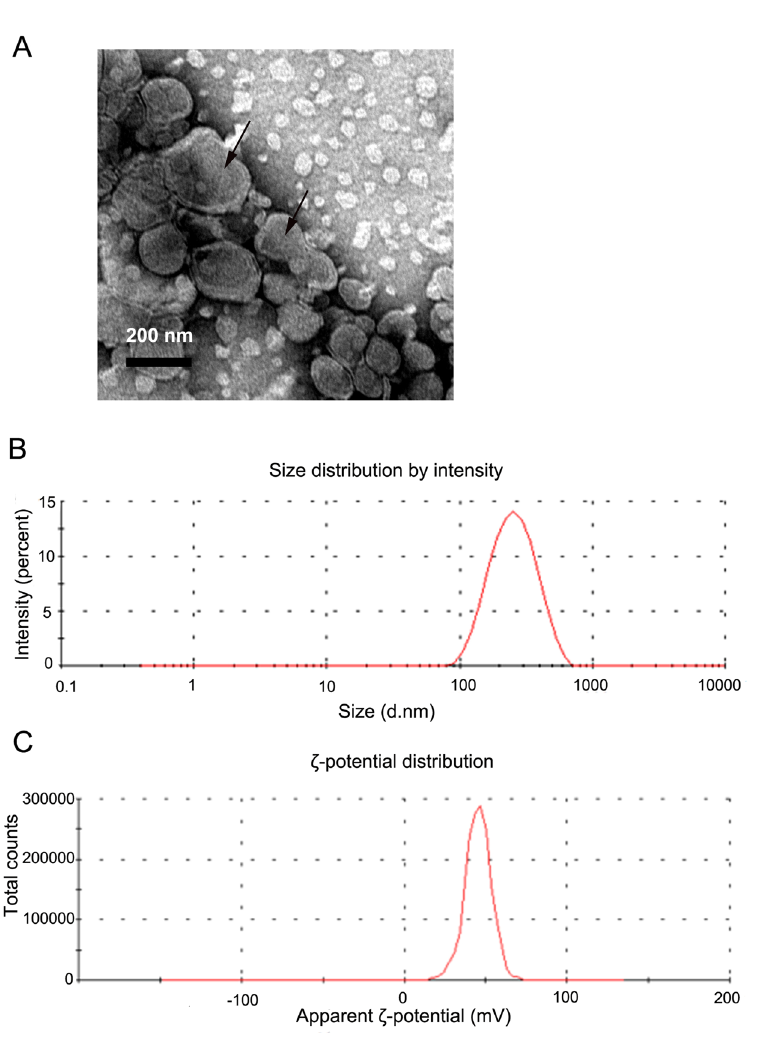
Figure 1. TEM photo showing 220-nm diameter liposomes and their distribution following phosphotungstic acid staining ( A ). The particle distribution ( B ) and ζ -potential ( C ) of